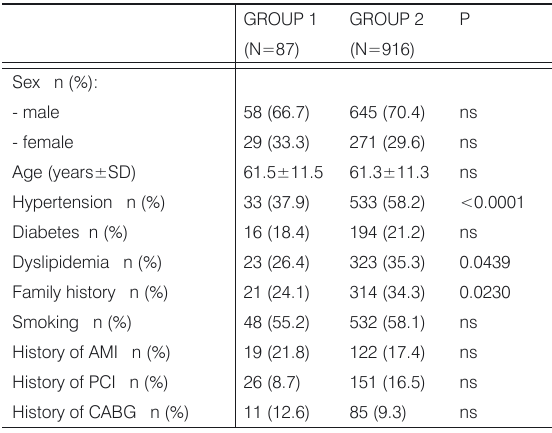
Table 1. Baseline